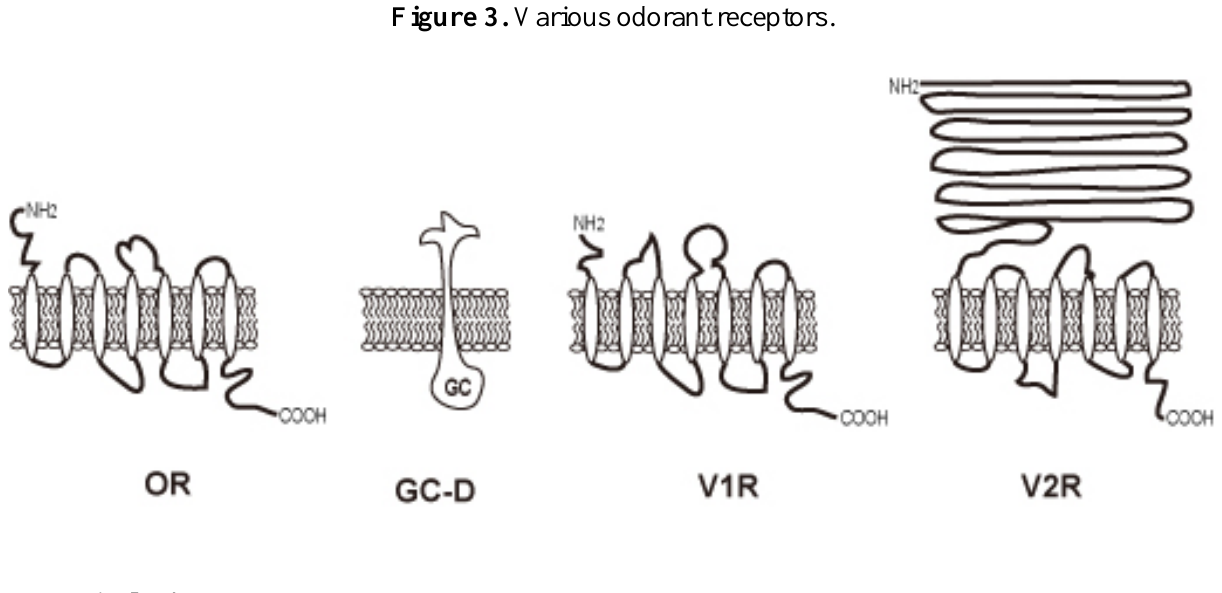
Figure 3. Various odorant